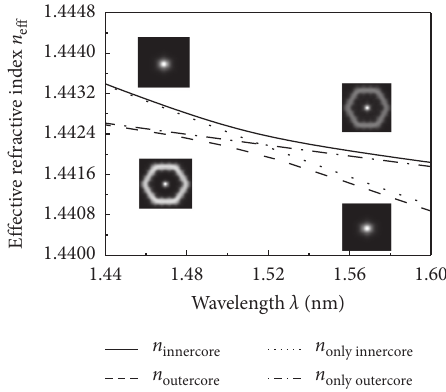
Figure 2: Effective index of inner core fundamental (solid line), outer core second-order mode (dashed line), and only inner core or only outer core fundamental mode (dotted or dash-dotted line). Insets show the modal field distributions of inner core fundamental mode and outer core second-order mode.